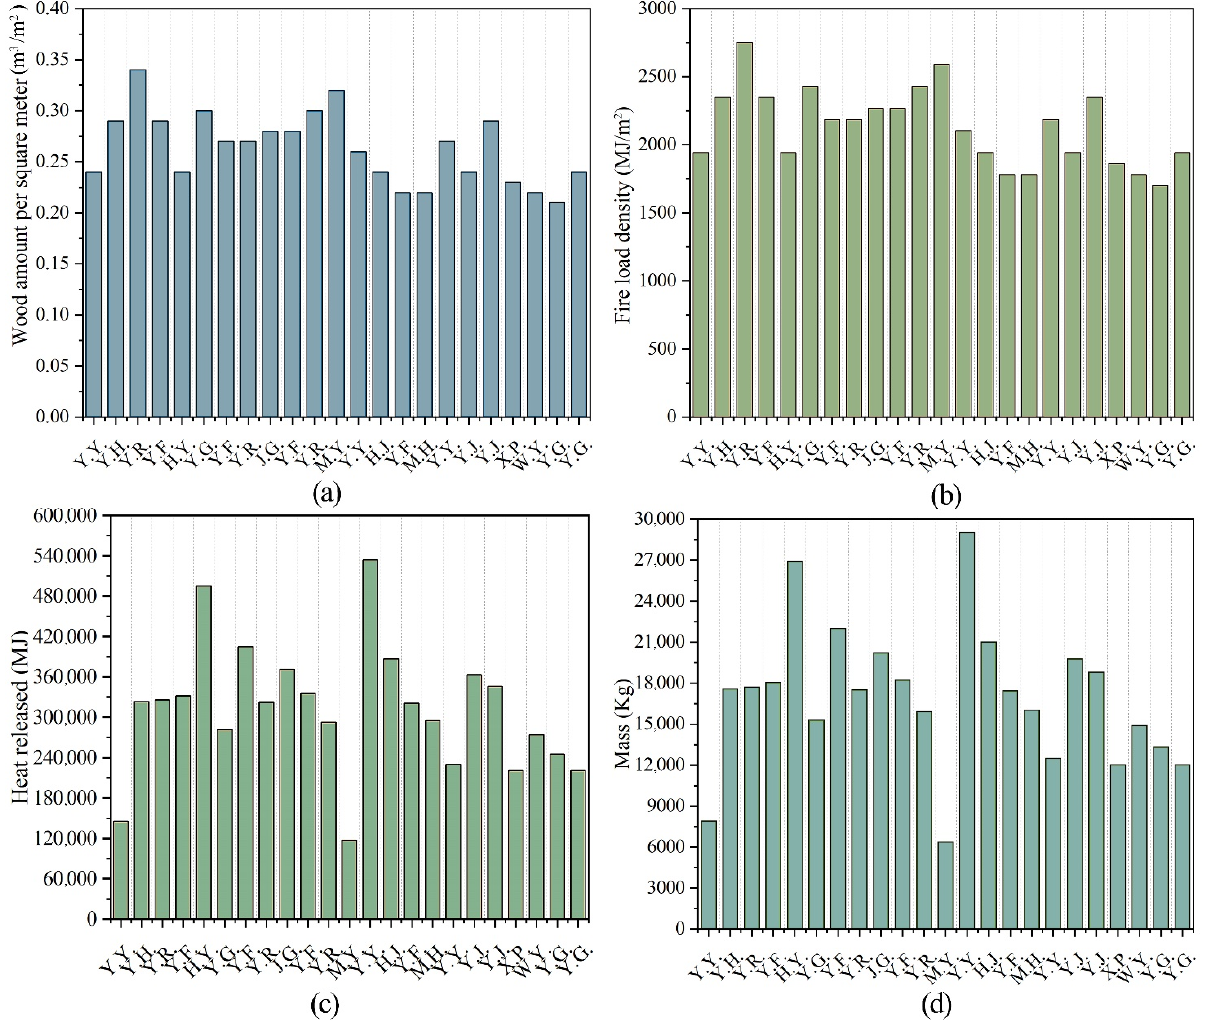
Figure 13. The estimated fire load results of the residential buildings in High chair Village. ( a ) fire load capacity; ( b ) fixed fire load density; ( c ) heat released; ( d ) mass.